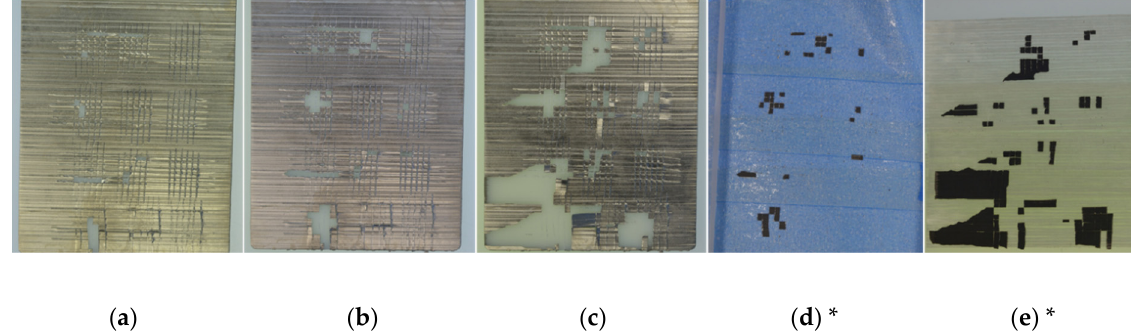
6 of 14 Figure 1. Testing equipment for inductive heating: ( a ) Test setup consisting of a test specimen on an insulation board with the inductor placed below; hookup system for electricity and coolant (water); ( b ) Pancake inductor fabricated from 8 mm copper tubing.